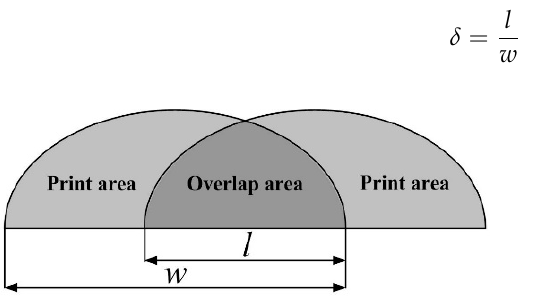
Figure 3. Schematic diagram of the overlap region formed between two adjacent